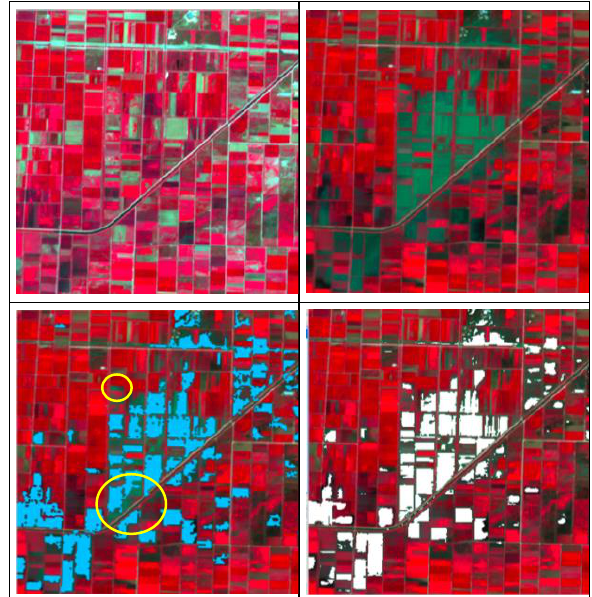
Figure 6. Sentinel-2 pre-event (upper left) and post-event (upper right) pseudo-colour visualizations, Copernicus-EMS vector output in cyan (lower right) and our approach’s output in white (lower left) over a subset of the area of interest.